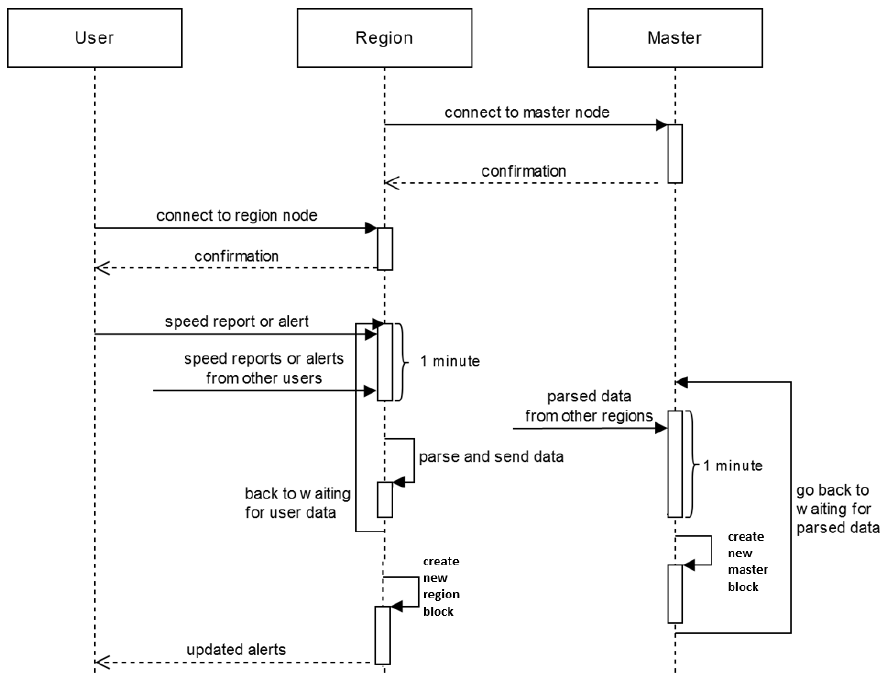
Figure 3. Solution